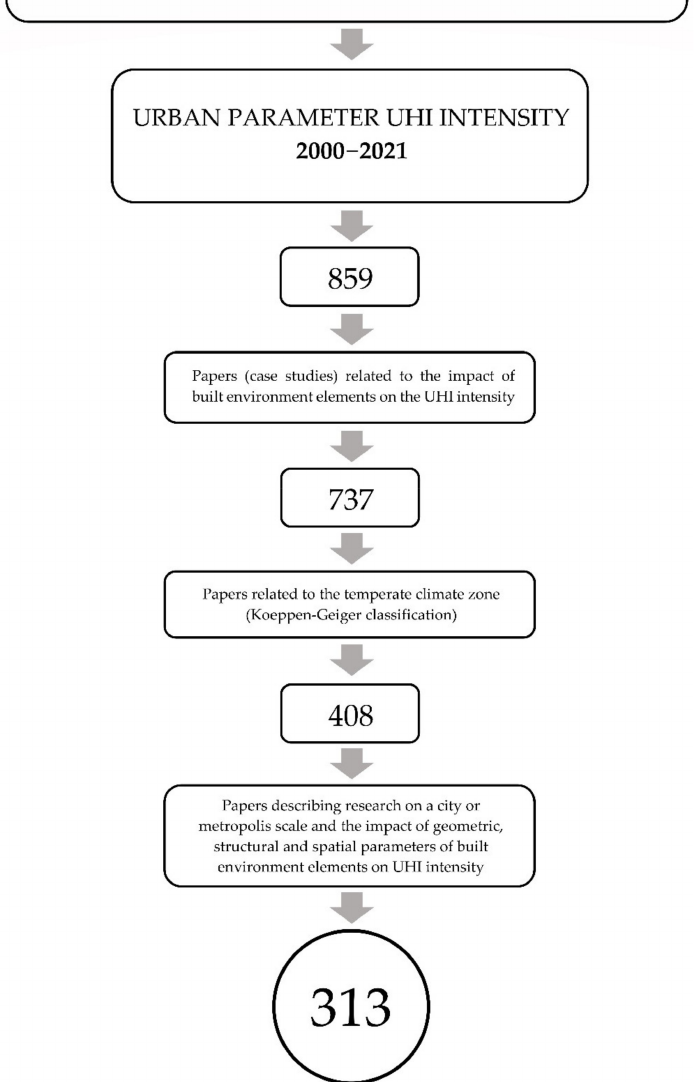
Figure 1. Logical diagram of papers selected for the